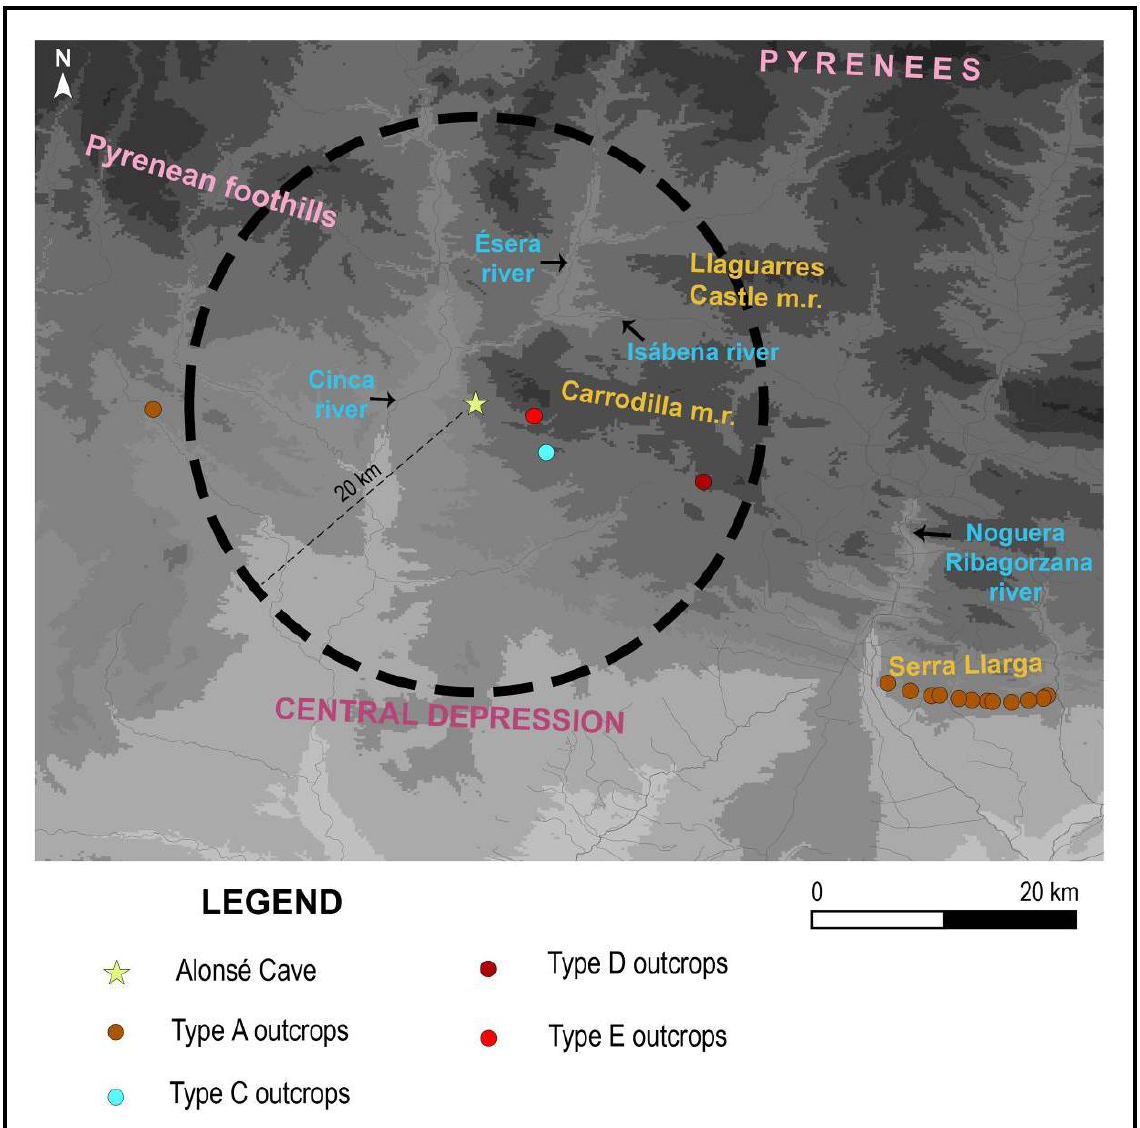
Figure 5. Alonsé Cave and the different geological formations with parallels in the archaeological